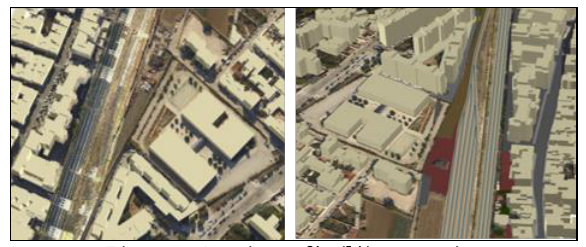
Figure 7 - 3D views of building extrusions.